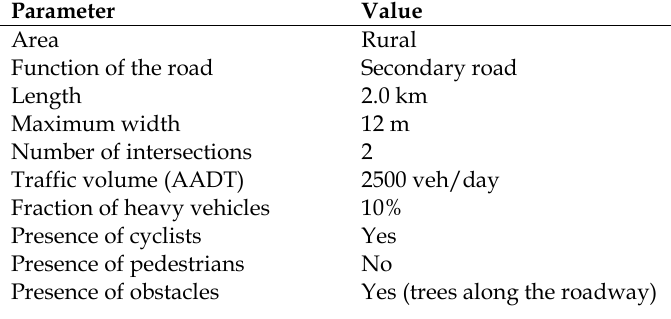
Table 4. Description of the case